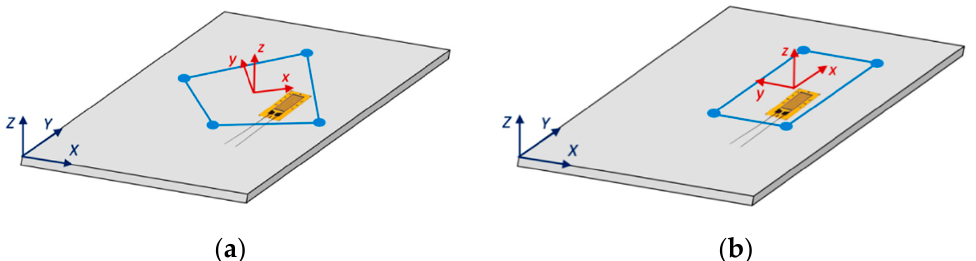
Figure 3. Strain transformation from global to element ’ s local reference system: ( a ) Element with an arbitrary shape and orientation; ( b ) rectangular element aligned with the strain gauge rosette.